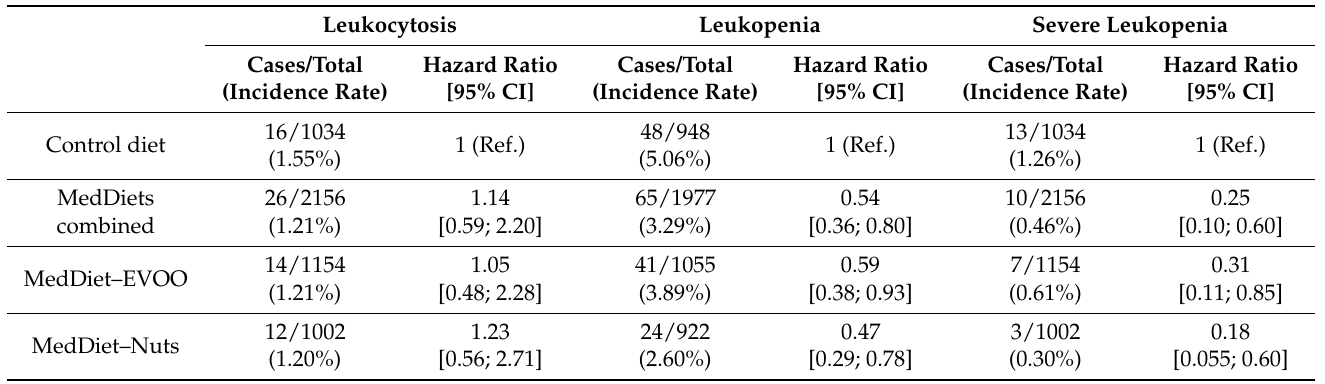
Table 2. Incidence of white blood cell count alterations in the study population 1 .